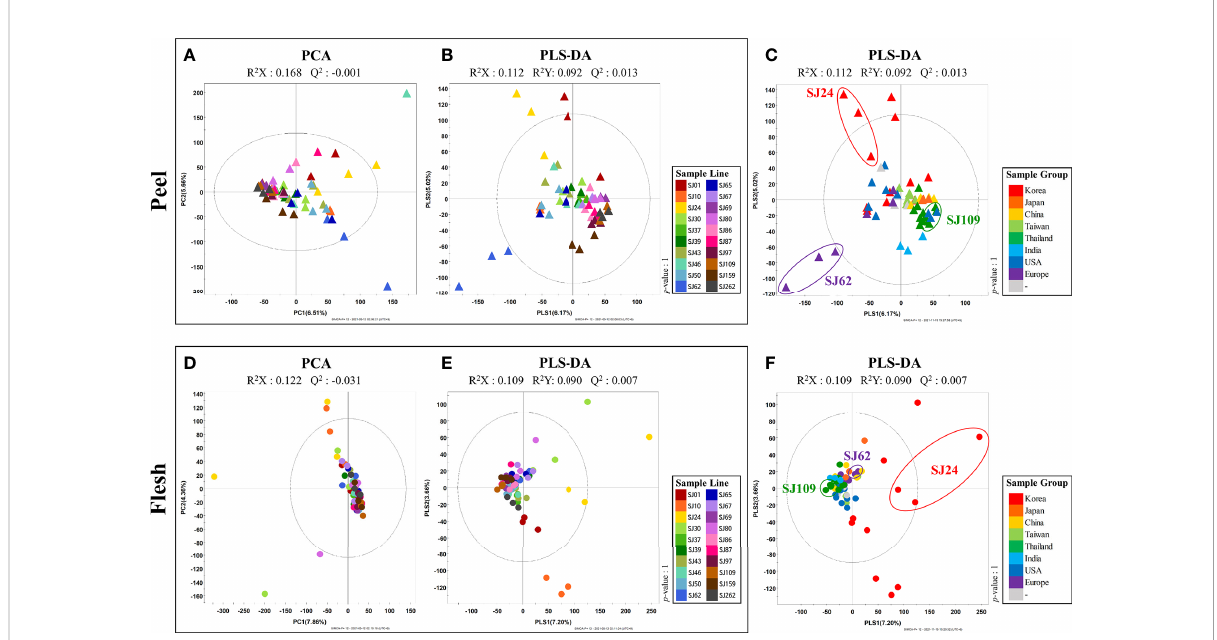
FIGURE 2 PCA and PLS-DA score plots of 20 cucumber breeding lines of peel (A – C) and fl esh (D – F) based on HS-SPME-GC-TOF-MS data set. (A, B, D, E) indicate the color of sample line. (C, F) indicate the color of sample group. ▲ , peel; ● , fl